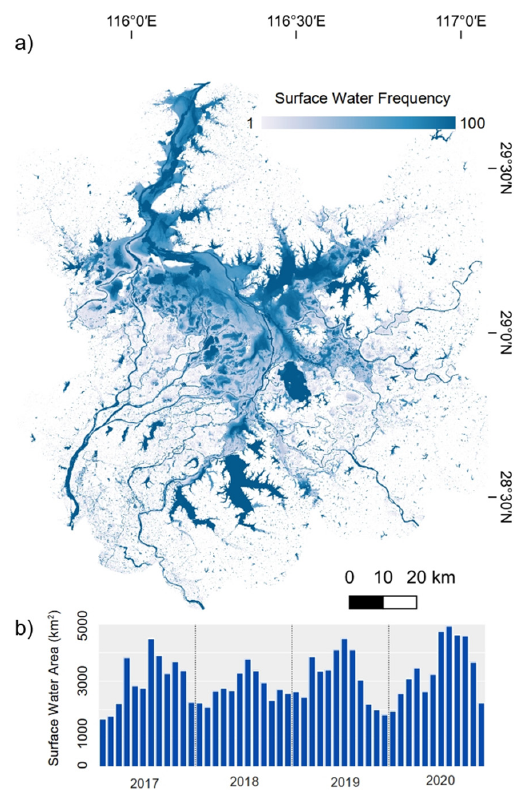
Figure 4. The multi-annual surface water frequency ( a ) and the associated inter-annual monthly water dynamics ( b ) for Lake Poyang.